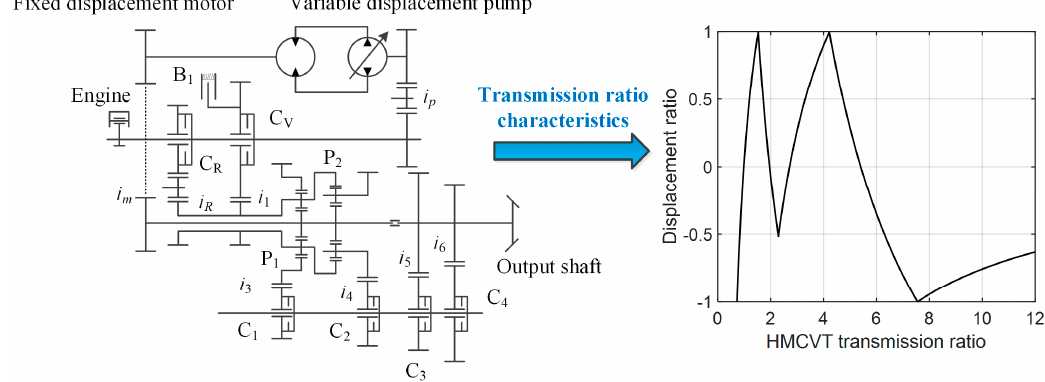
Figure 1. Transmission scheme and transmission ratio characteristics of a novel five-stage